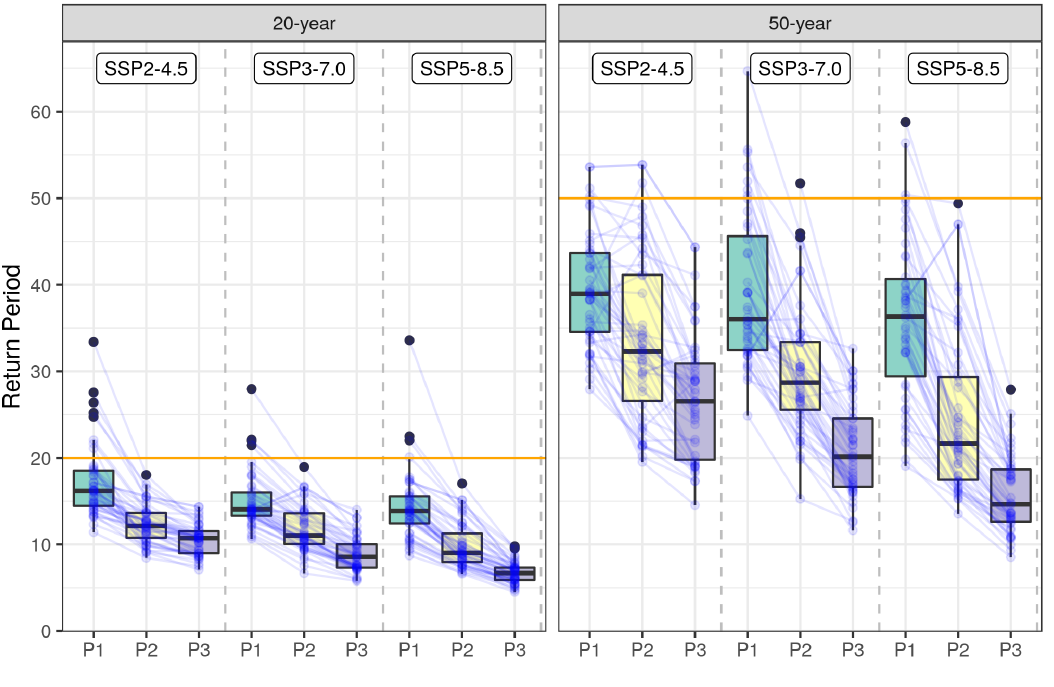
Figure 9. Parallel coordinated boxplots, similar to those in Figure 7, but for 20- and 50-year return periods relative to the observations from 1973 to